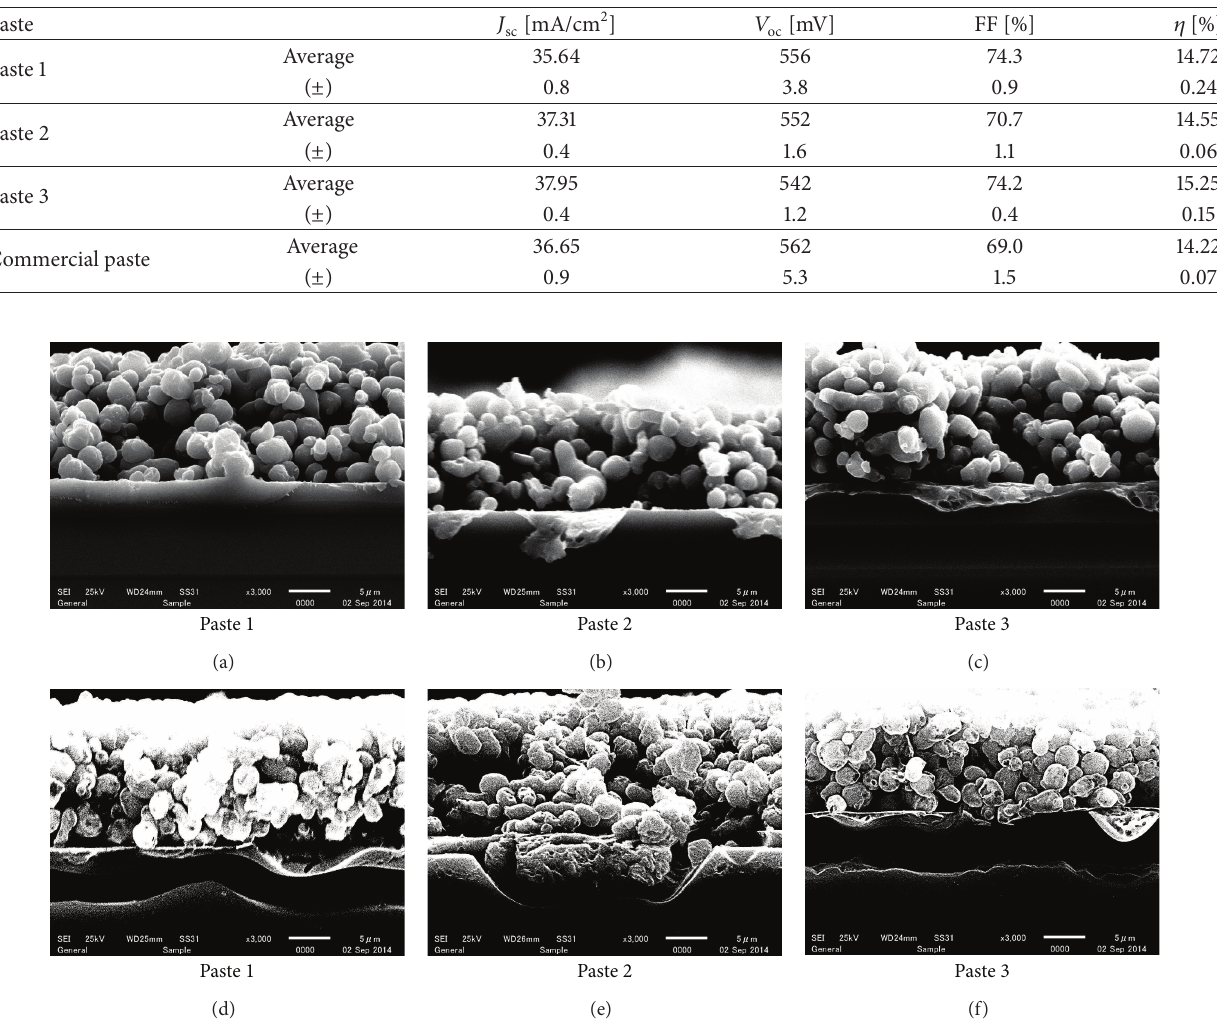
Figure 3: SEM images of fabricated cells using each paste before etching with acidic solution (a), (b), and (c) and after chemical etching (d), (e), and (f), for Paste 1 , Paste 2 , and Paste 3 ,